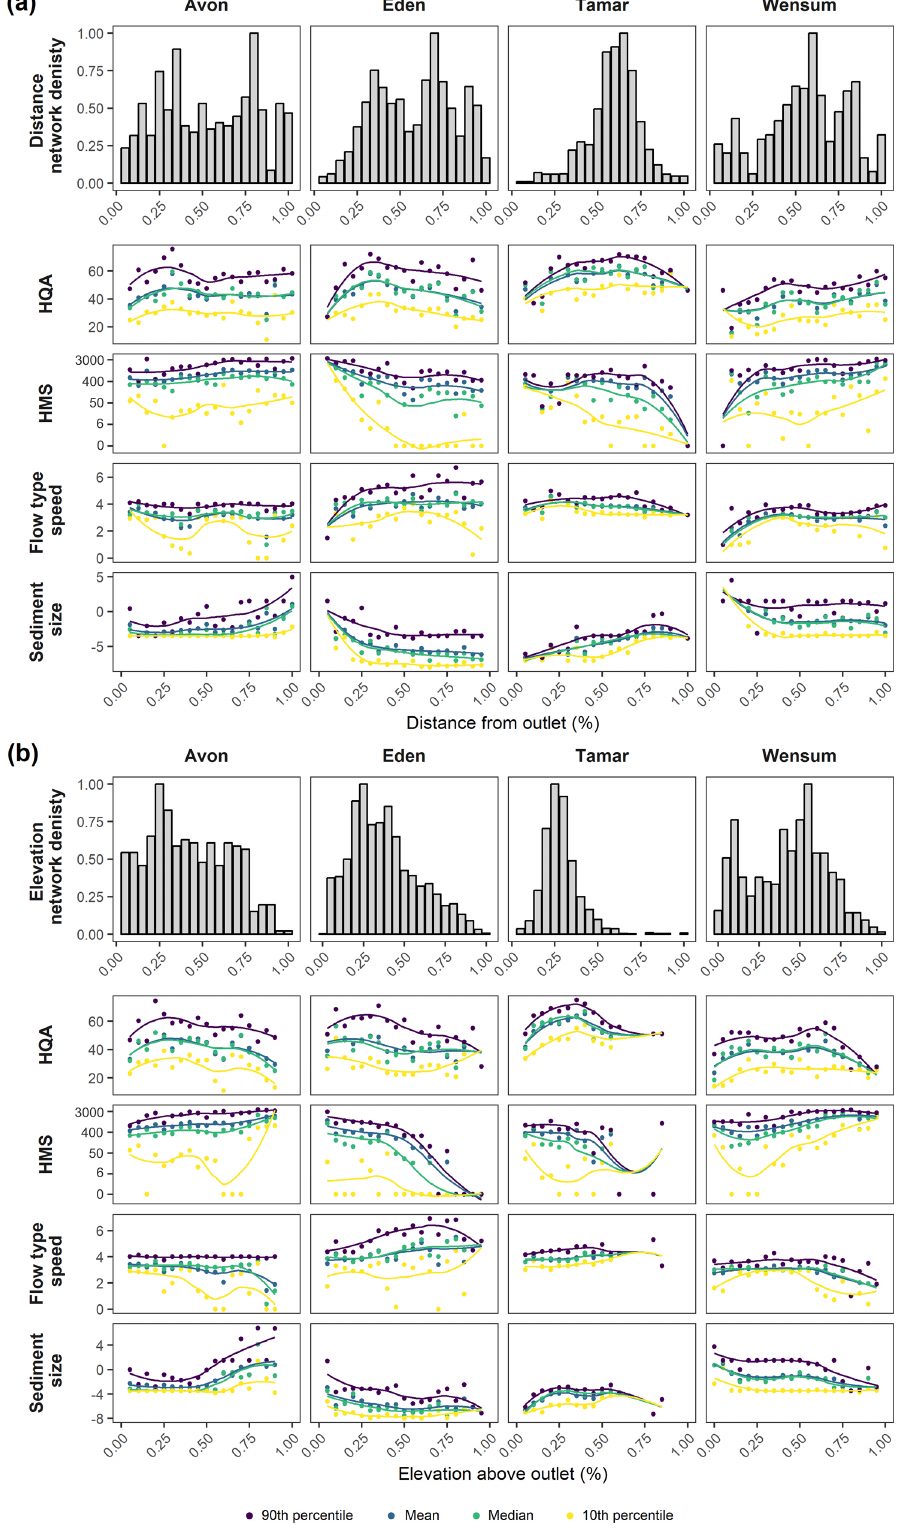
Figure 3. Network topology metrics (a) distance network density and (b) elevation network density. Descriptive statistics of each RHS variable over (a) distance and (b) elevation for each catchment with smooth loess lines to indicate trend. Network topology metrics are normalized between 0 and 1 and HMS score is logarithmically transformed for display